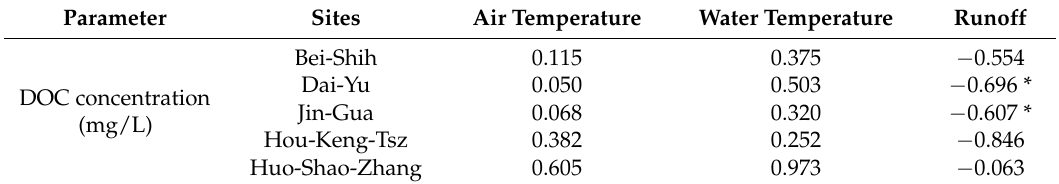
Table 4. Correlations between hydrological and meteorological factors with stream DOC concentrations. Parameter Sites Air Temperature Water Temperature